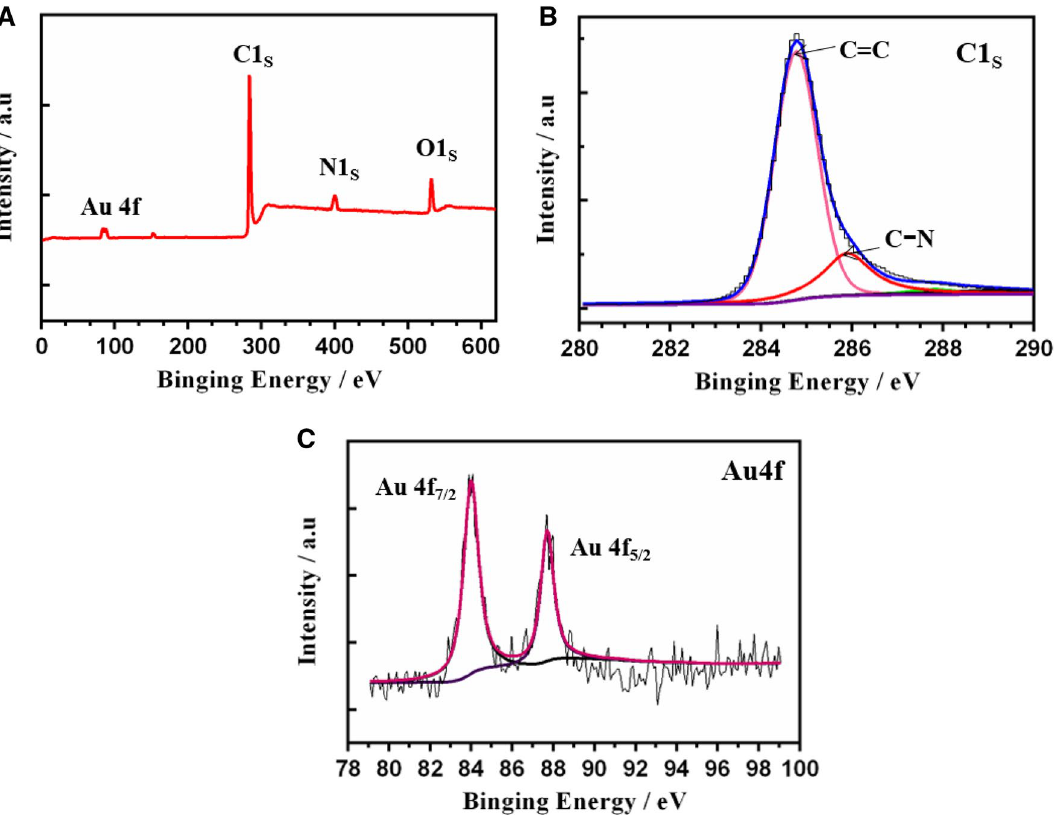
Figure 3. ( A ) X-ray photoelectron spectra of Au NC/MWCNTs-NH 2 . ( B ) High-resolution C 1 s and ( C ) Au 4f. narrow scan of Au NC/MWCNTs-NH 2